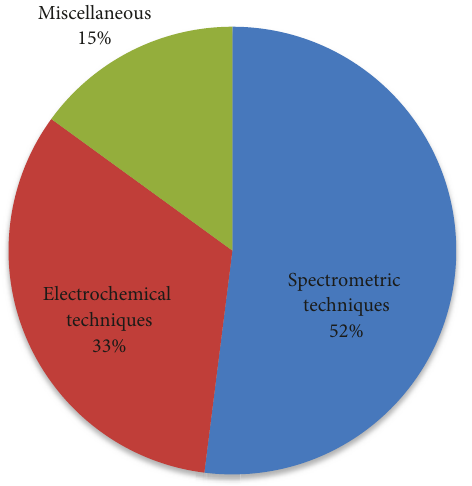
Figure 1: Determination and speciation of mercury using various analytical